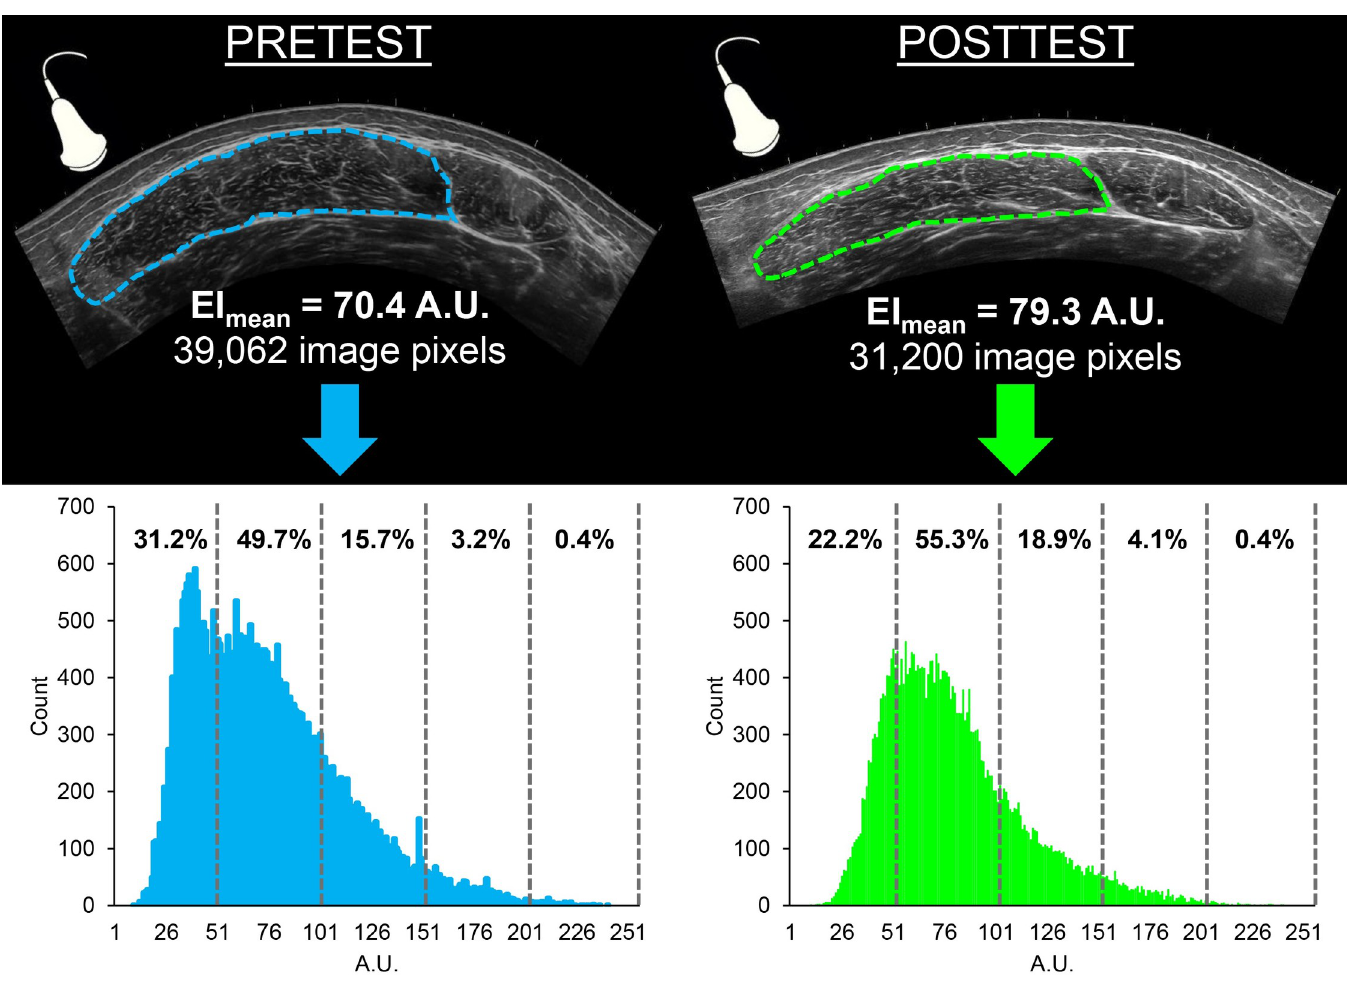
Fig 2. Example pretest (left) and posttest (right) B-mode ultrasonography images of the immobilized vastus lateralis for one participant. The borders of the vastus lateralis muscle have been outlined. The corresponding EI histograms, with the percentage of total number of pixels for each region (i.e., 0–50, 51–100, 101–150, 151–200, and 201–255 A.U.) are shown beneath each respective image. Note the shift in the histogram observed following